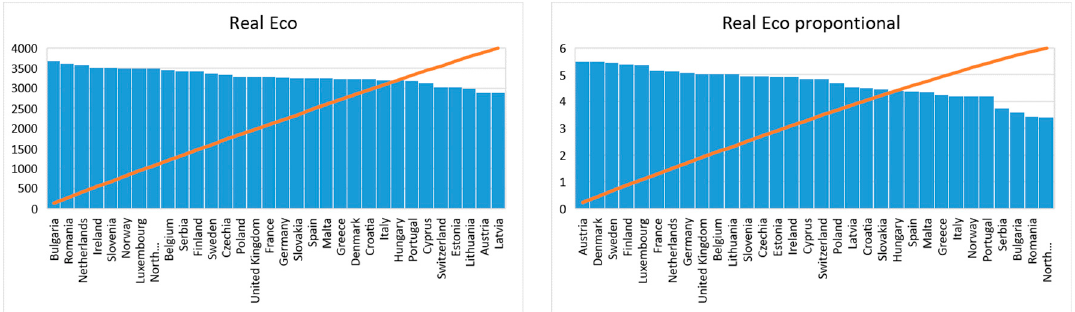
Figure 26. Compared real values, Eco factors.